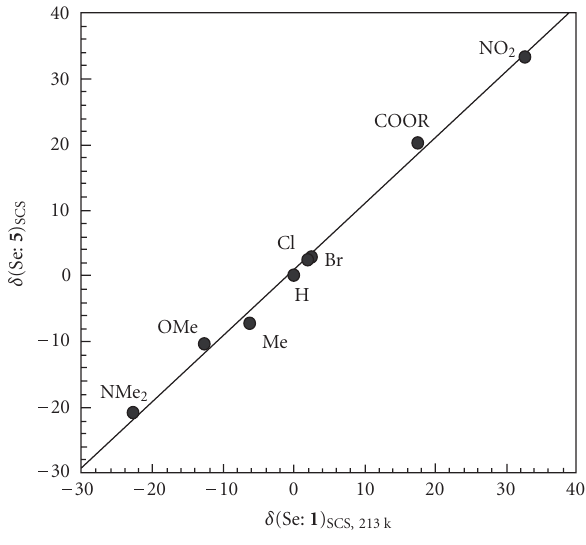
Figure 5: Plot of δ (Se: 5 ) SCS versus δ (Se: 1 ) SCS, 213K .